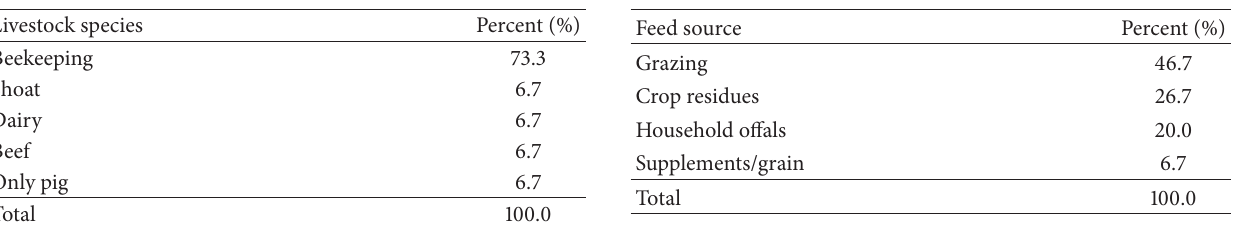
Table 4: Livestock holding of pig keeper respondents ( 𝑁 = 90 ). Table 5: Feed sources of pig ( 𝑁 = 90